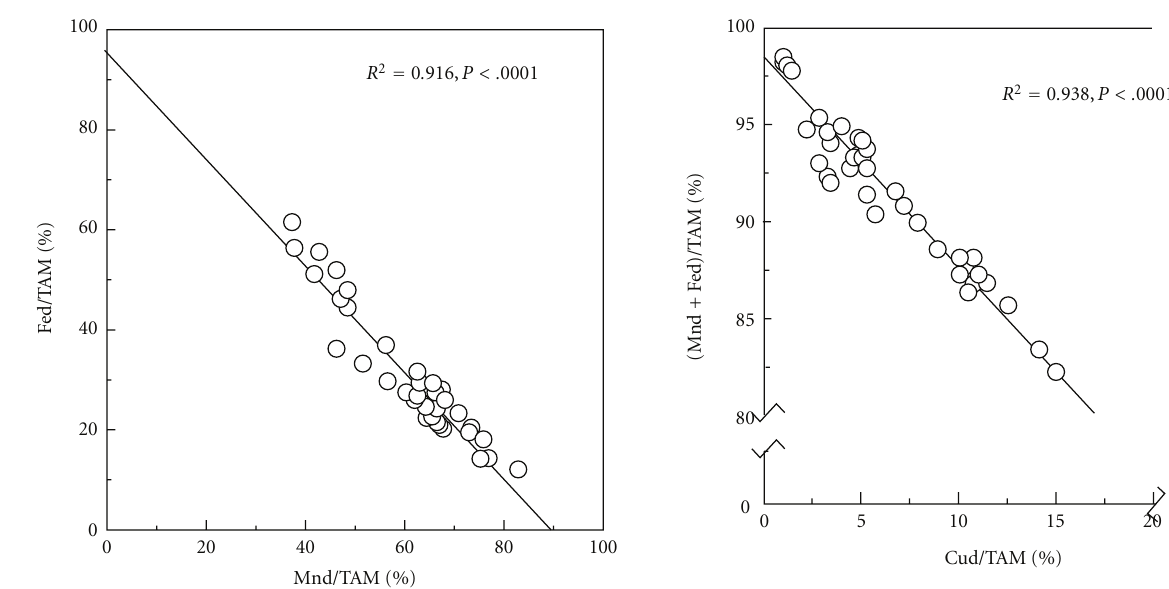
Figure 6: Relationship between Cud/TAM (%) and (Mnd + Fed)/TAM (%). (TAM = total amount of available micronutrients; Mn d + Fe d + Cu d + Zn d + Cd d